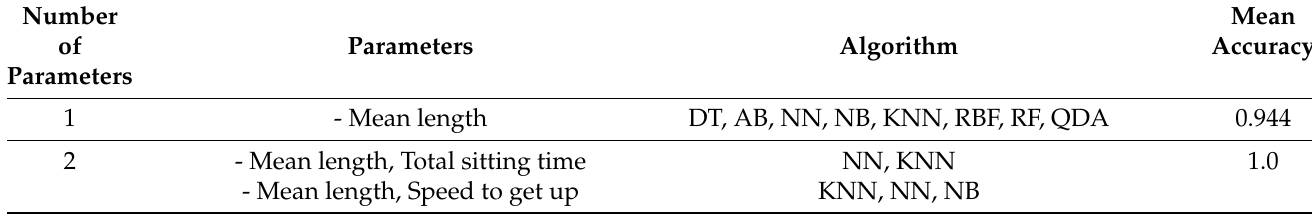
Table 3. Best parameter combinations for the two classes problem. The best classification score is presented in the fourth column. A score of 1 is the best possible score, i.e., without any classification error. The third column indicates the algorithms underlying the best classifications with Decision Tree: DT, AdaBoost: AB, Neural Net: NN, Naive Bayes: NB, Nearest Neighbors: KNN, Radial Basis Function: RBF, Random Forest: RF and Quadratic Discriminant Analysis: QDA. Number Mean of Parameters Algorithm Accuracy